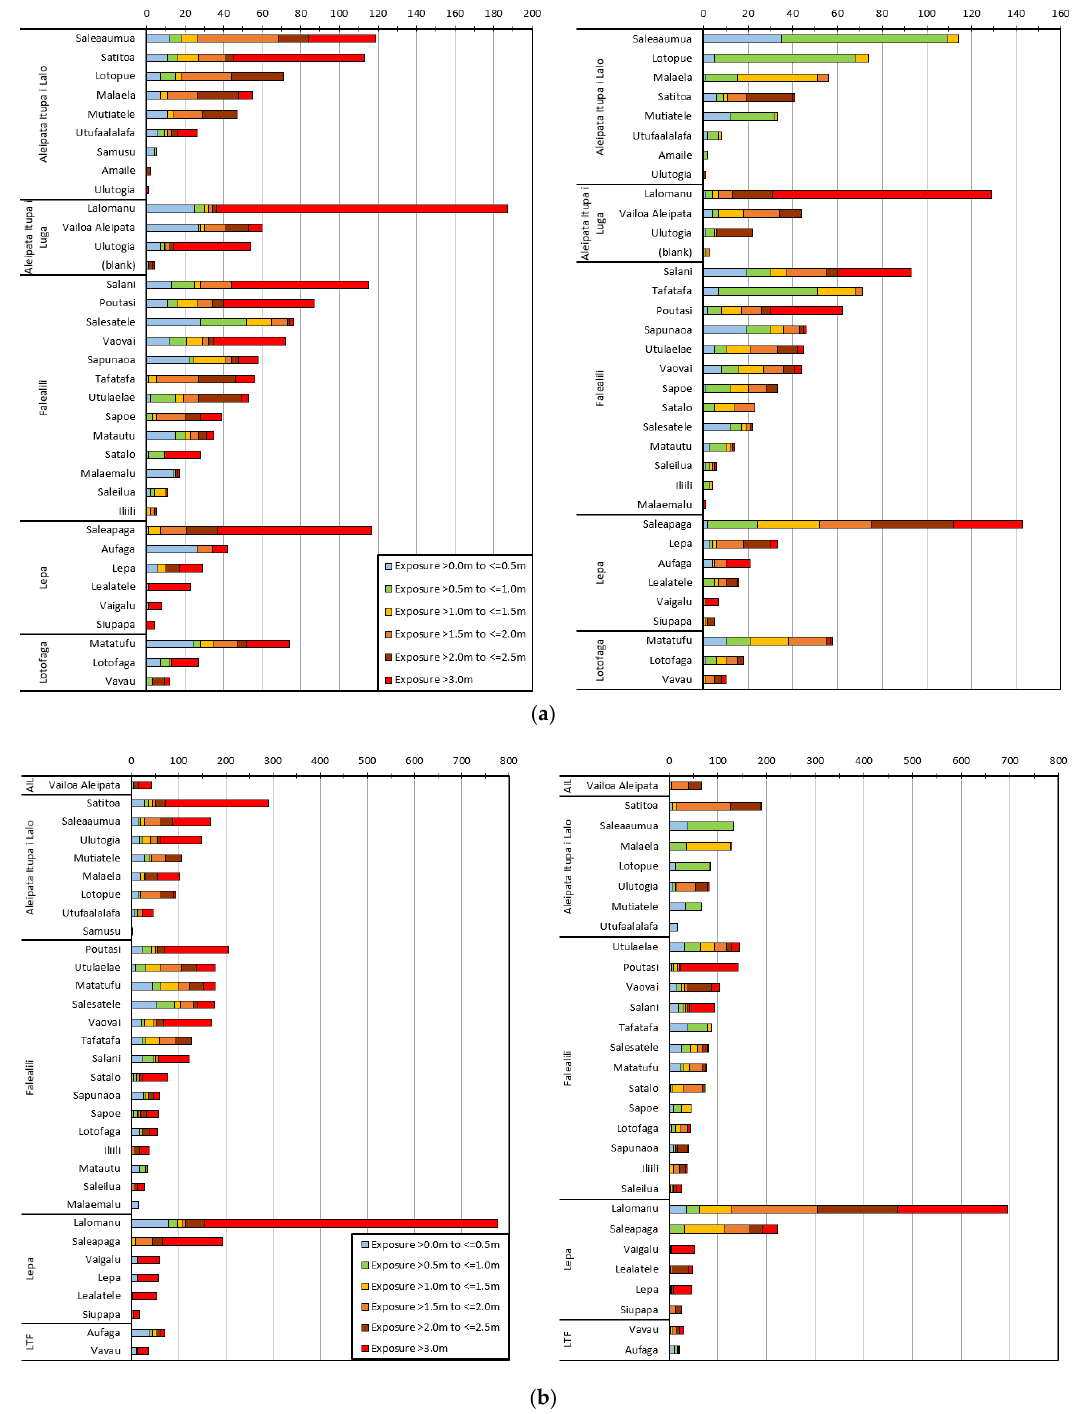
Figure 5. ( a ) Comparison of the sum of buildings exposed in Southeast Upolu: 50 m exposure results (left) and 10 m exposure results (right). ( b ) Comparison of road lengths (m) exposed: 50 m exposure results (left) and 10 m exposure results (right). AIL = Aleipata Itupa I Luga; LTF = Lotofaga.